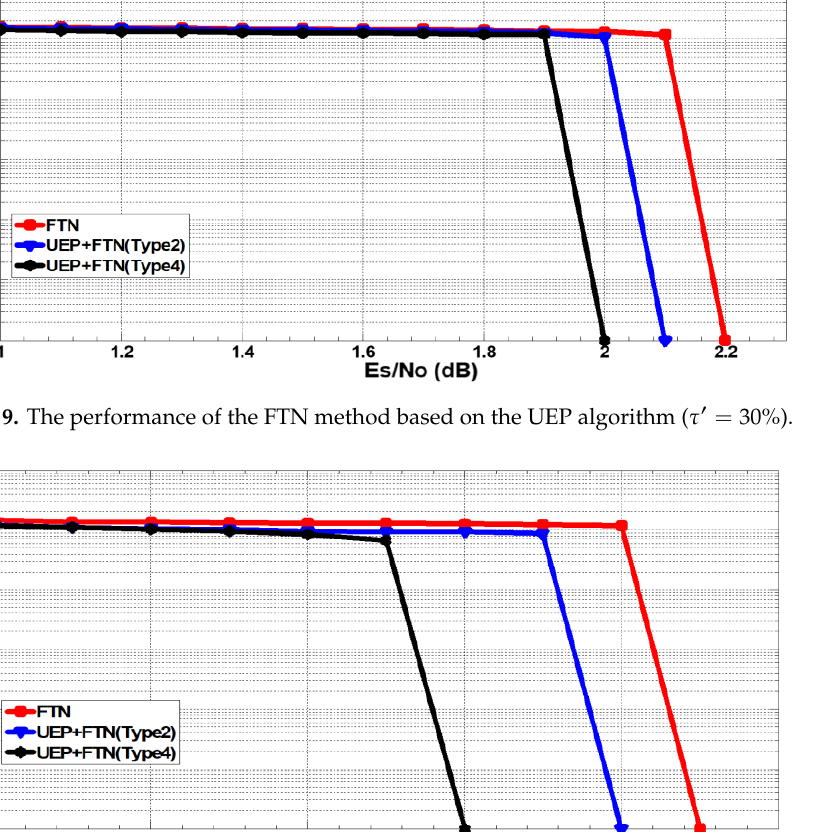
Figure 10. The performance of the FTN method based on the UEP algorithm ( 𝜏 ′ = 40% ).